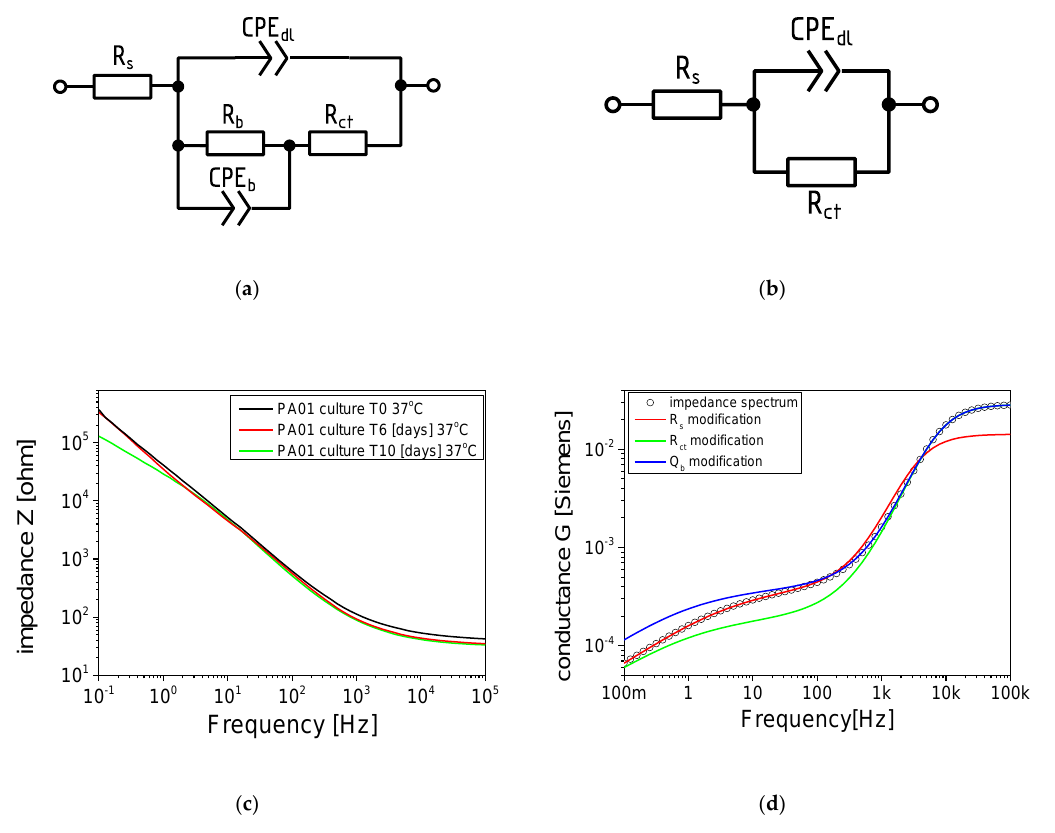
Figure 2. Primary ( a ) and simplified ( b ) electric equivalent circuits (EECs) used for the analysis of measured impedance spectra; ( c ) impedance spectra of quartz tuning forks (QTF) in P. aeruginosa PAO1 10-days biofilm culture, and the influence of EEC parameters change to the shape of conductance spectrum ( d ).